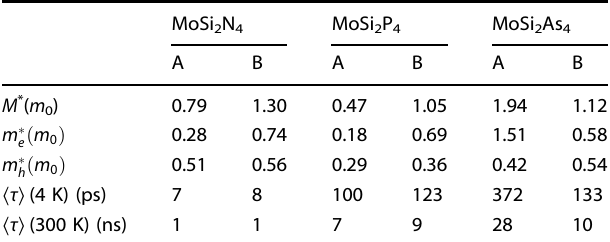
Table 1. Effective exciton masses and fi nite temperature radiative lifetimes.